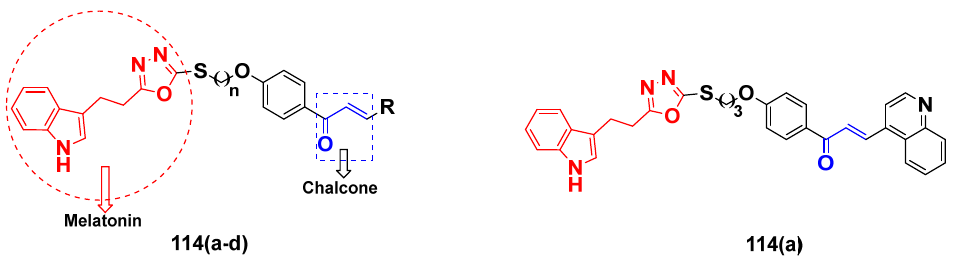
Figure 109. Structure of chalcone based melatonin hybrids and the most promising compound 114a . Table 96. In vitro cytotoxic activities of chalcone based melatonin hybrid compounds [ 114 ( a – d ), 114 ( a )].